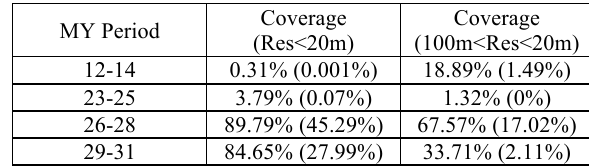
Table 3: Martian surface coverage statistics during different time periods. In parentheses is reported the surface percentage that was mapped more than 3 times over the same time period.